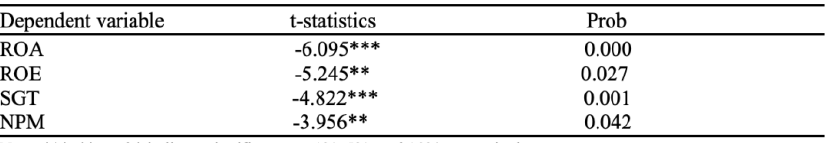
Table 3: Kao Residual Panel Co-integration results